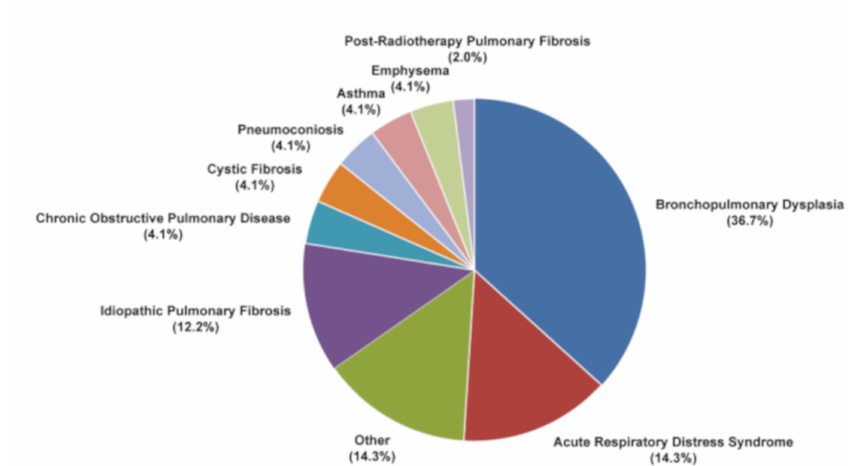
Figure 6. Mesenchymal stem cell-based clinical trials in lung diseases. Search for clinical studies reported in https: // clinicaltrials.gov database using “Mesenchymal Stem Cells” and “Lung Disease”